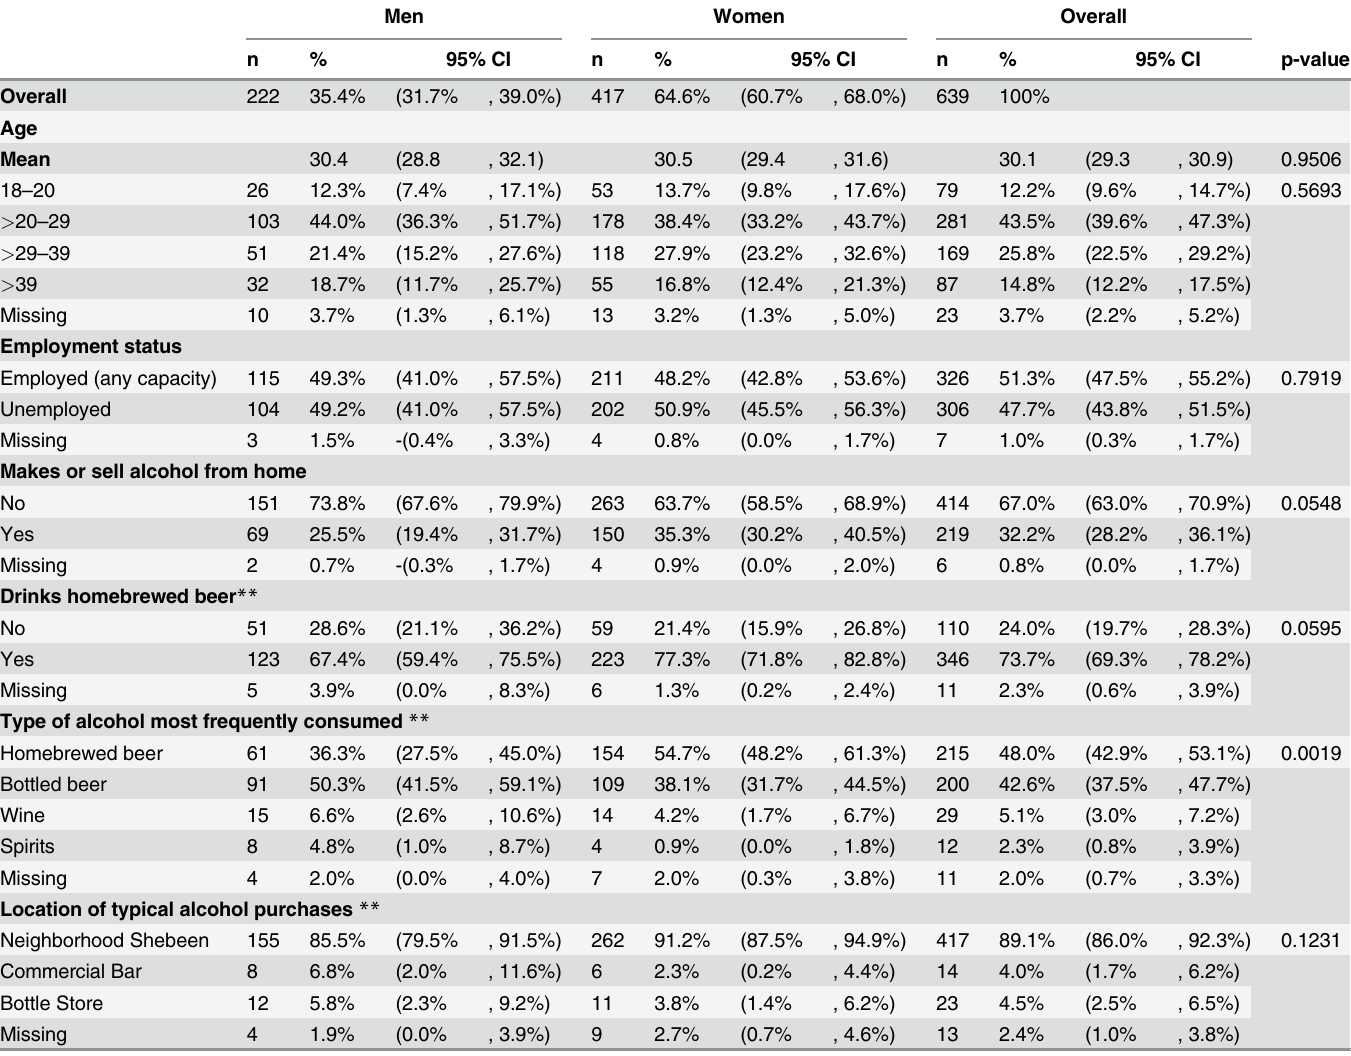
Table 1. Demographic Characteristics *